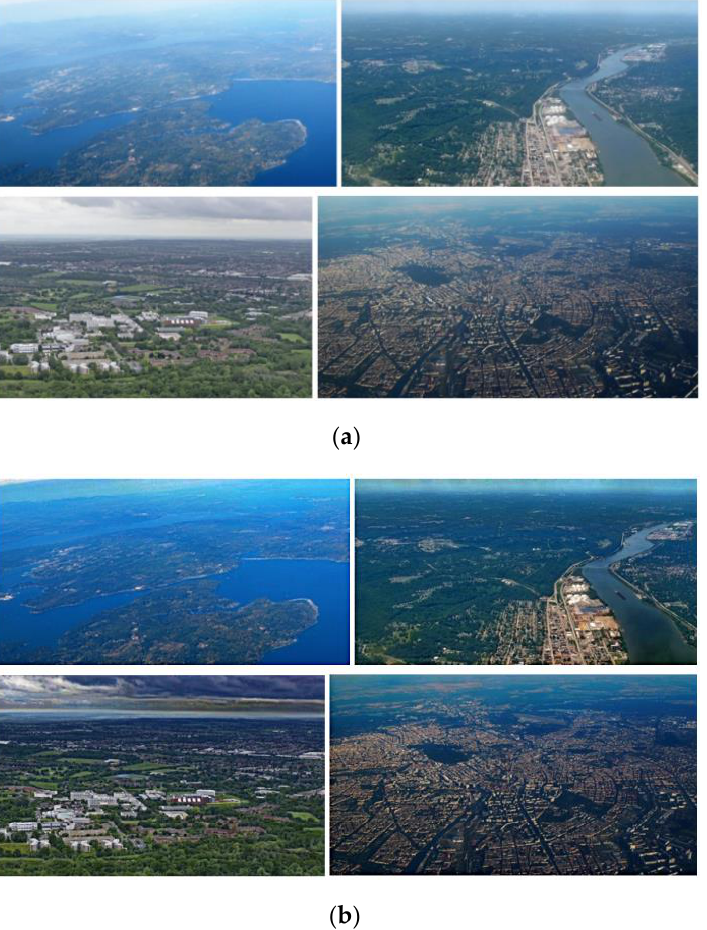
Figure 3. Test aerial images and dehazing result with large sizes: ( a ) original hazy images and ( b ) proposed method.